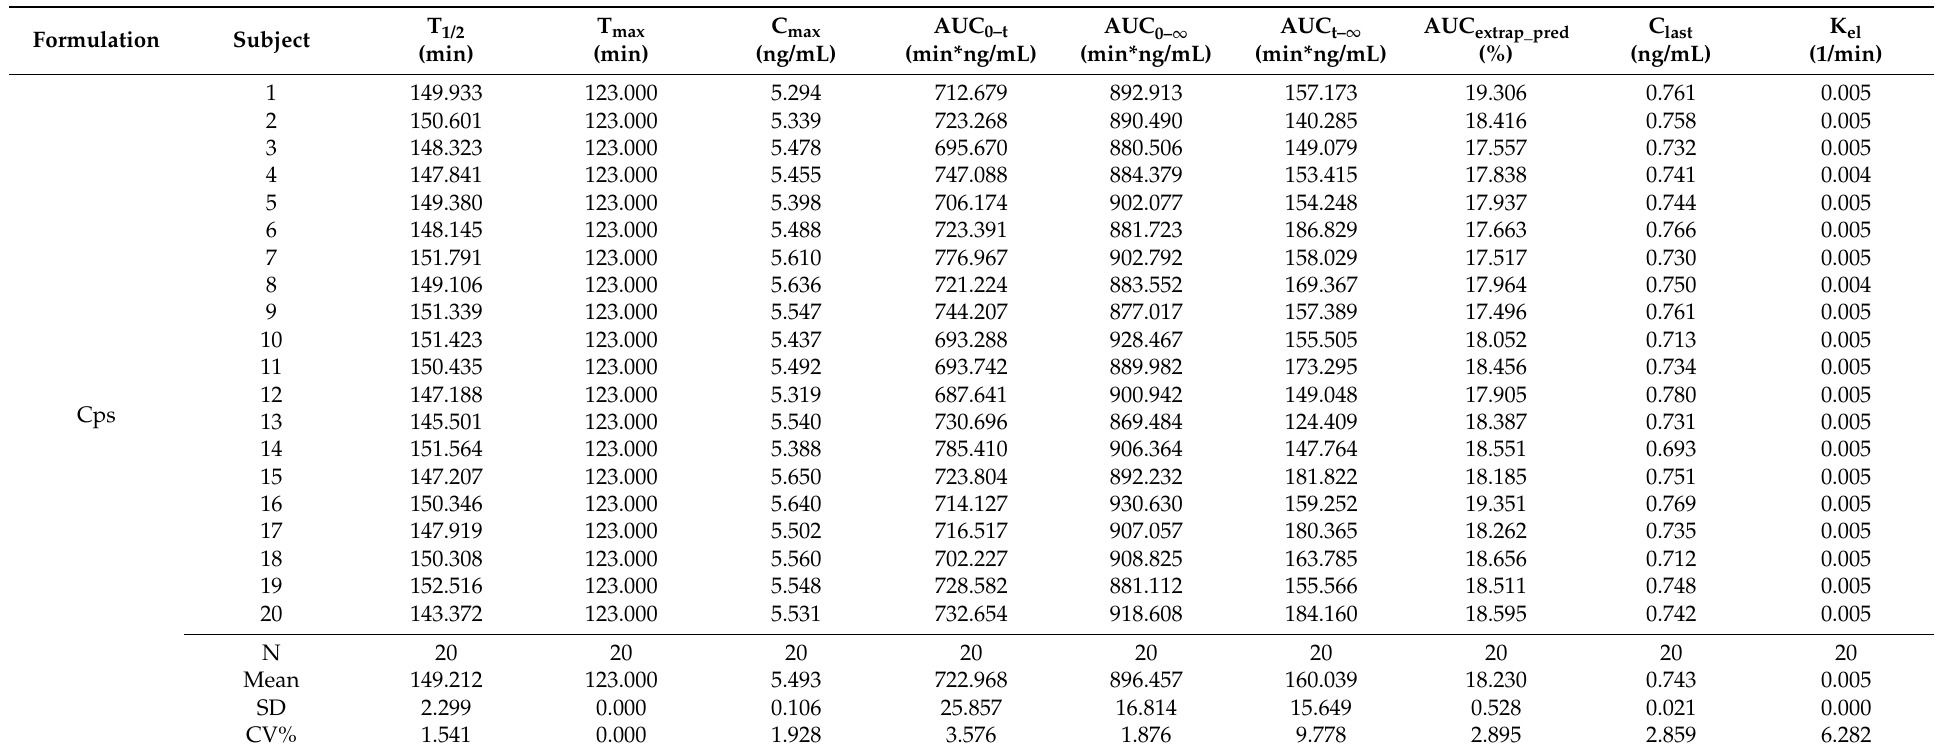
Table 3. Pharmacokinetic parameters (mean ± standard deviation) in humans following oral administration of 15 mg of hydroxytyrosol (3,4-dihydroxy- phenylethanol, DOPET) ( n =